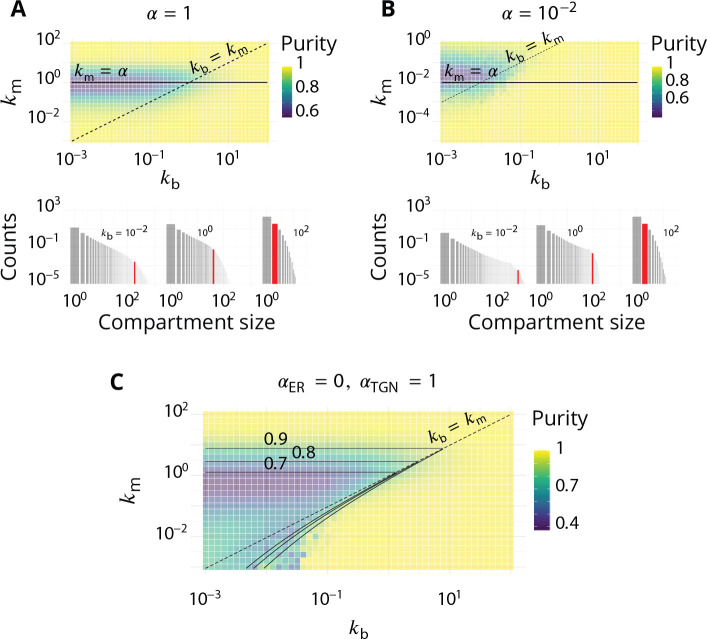
Impact of the composition of the boundaries of the system (ER and TGN) on the steady-state organisation.Related to Figure 2 - main text. (A–B). The fraction α of active species driving homotypic fusion with the boundaries are identical for the ER and the TGN. A. α=1 (same value as in the main text) B. α=10-2. For both cases, the top panel is the purity diagram as a function of the normalized biochemical conversion rate km and budding rate kb. Dashed lines correspond to km=kb and solid lines to km=α. For both cases, the bottom panel shows some examples of the size distribution for km=α and different values of kb. (C) Purity diagram as a function of km and kb when fusion with the ER is abolished: αER=0 whereas αTGN=1. Solid lines are the predictions of the analytical model developed in Appendix 3.